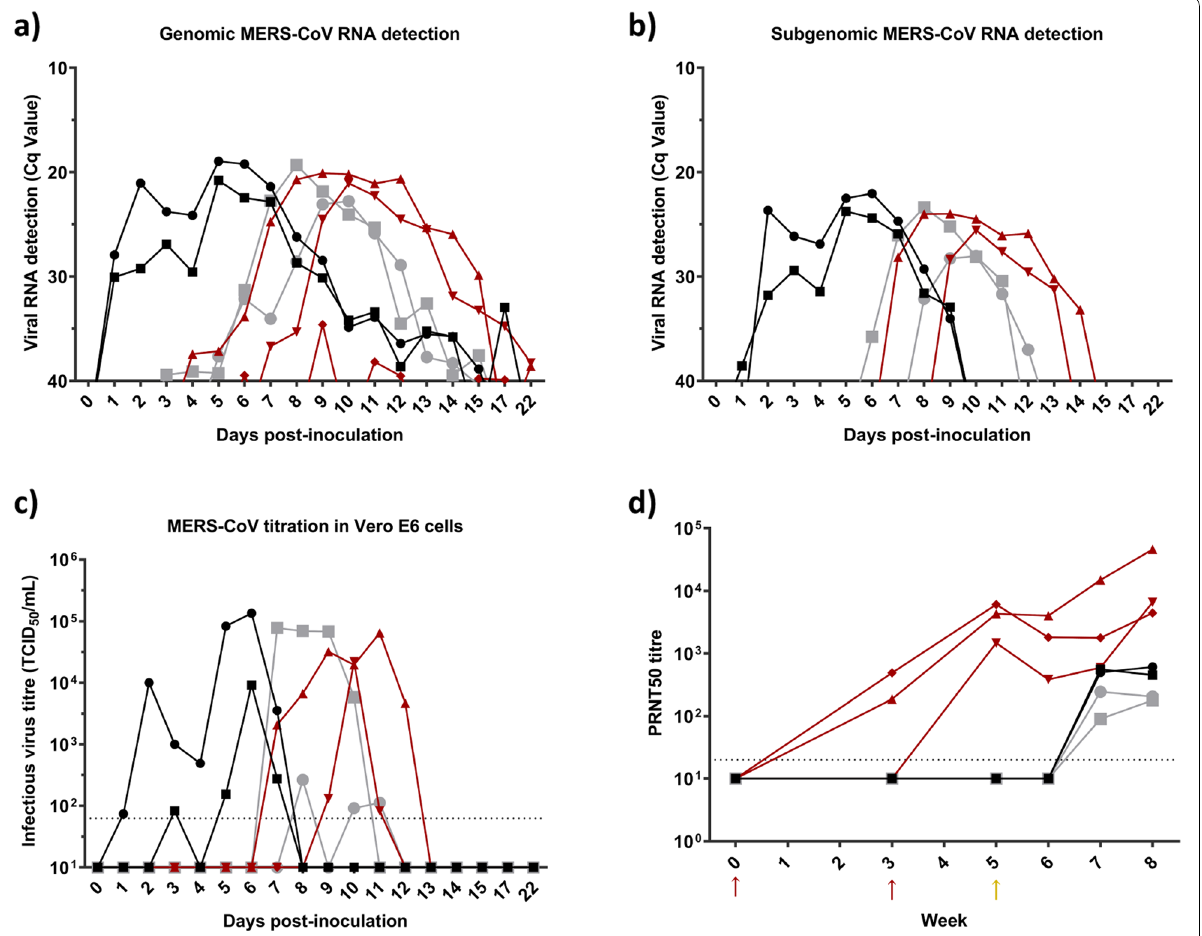
Fig. 2 MERS‑CoV RNA and infectious virus shedding and development of neutralizing antibodies in llamas. Experimentally infected llamas (black) were placed in contact with naïve (grey) and vaccinated (red) animals two days after MERS‑CoV inoculation. Genomic ( a ) and subgenomic ( b ) viral RNA was quantified in nasal swab specimens collected at different times after MERS‑CoV inoculation. Plot ( c ) show infectious MERS‑CoV titres in nasal swabs collected on different days after MERS‑CoV inoculation. Plot ( d ) displays serum neutralizing antibodies elicited against MERS‑CoV in vaccinated, experimentally inoculated and in‑contact naïve llamas. Each line represents an individual animal. Dashed lines depict the detection limits of the assays. Red and yellow arrows indicate the two MPSP‑RBD immunizations and MERS‑CoV inoculation days, respectively. Cq, quantification cycle; MERS‑CoV, Middle East respiratory syndrome coronavirus; PRNT50, 50% plaque reduction neutralization titre; TCID 50 , 50% tissue culture infective